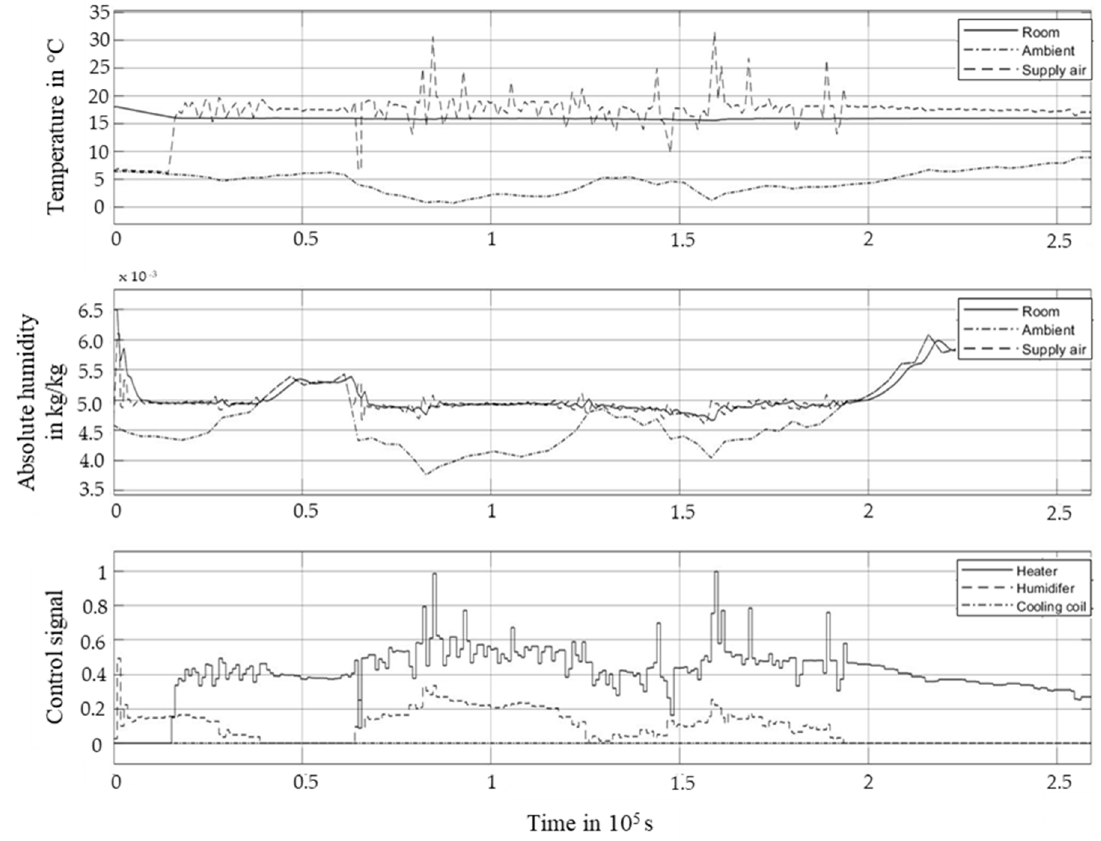
Figure 5. Energy-optimised and cost-optimised economic multiple model predictive control (EMMPC) with constant electricity price over three days in January.